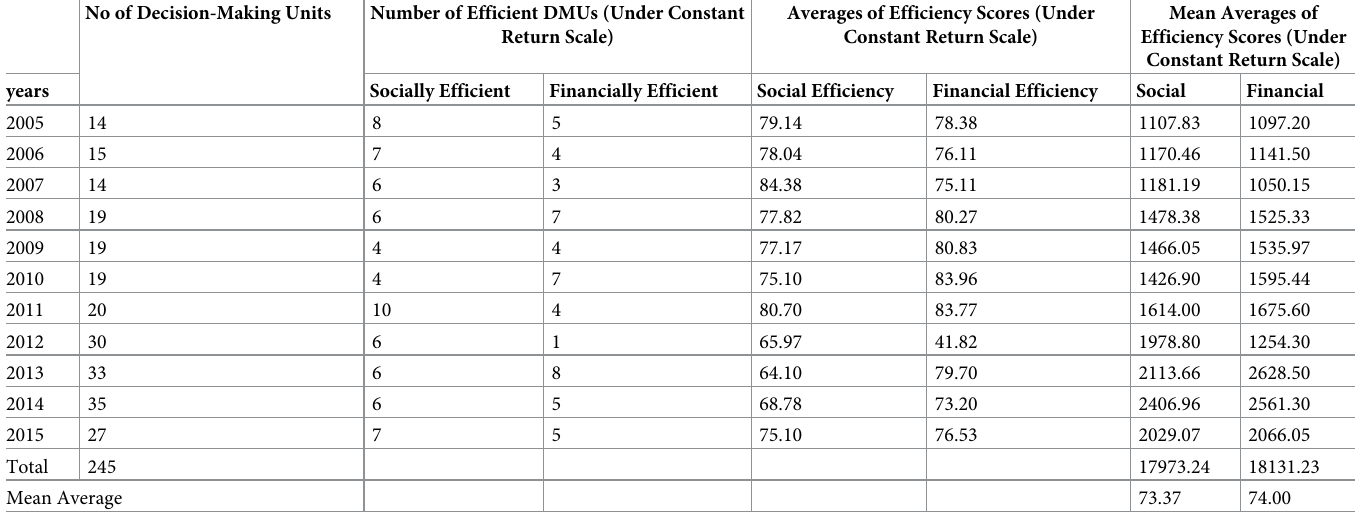
Table 2. Overall technical efficiency of partner organizations, operating under Pakistan Poverty Alleviation Fund (PPAF). No of Decision-Making